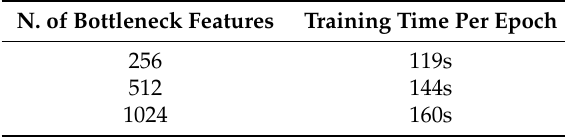
Table 5. Training times for different-sized Mini U-Nets for garbage